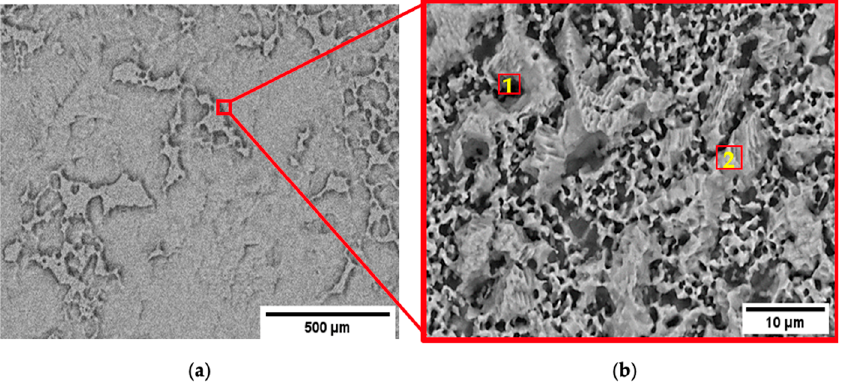
Figure 2. SEM/EDX analysis of the as extruded Zn-1.89M: ( a ) microstructure; ( b ) magnified window. Numbers give indications for the different phases present, EDX analysis in Table S1.